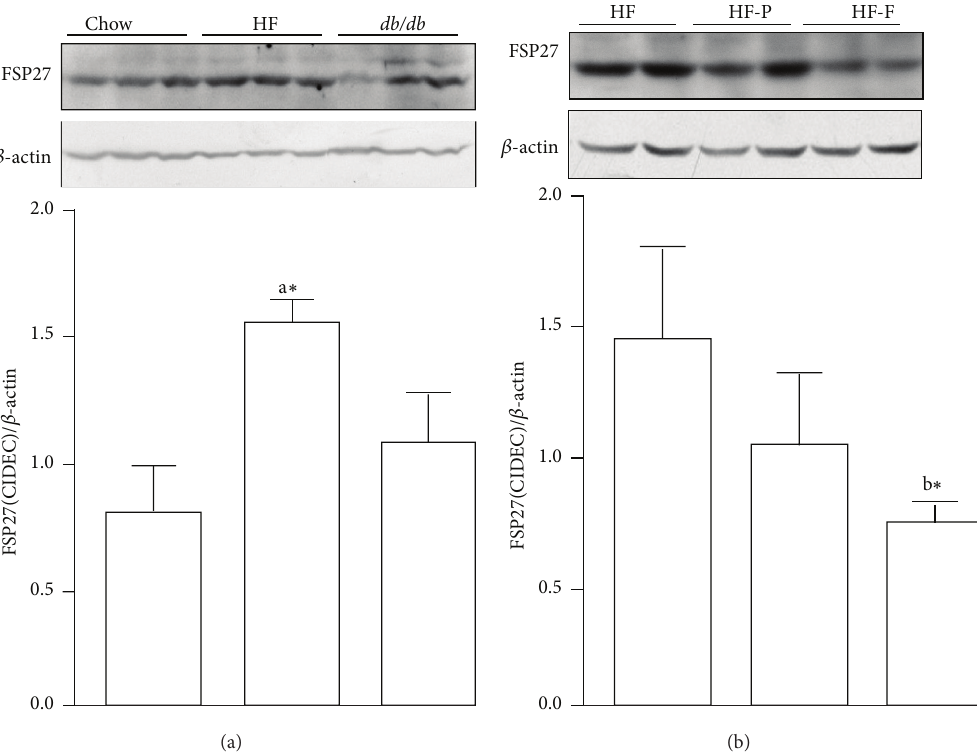
Figure 2: FSP27/CIDEC protein is highly expressed in mouse fatty liver. Immunoblot analyses of FSP27/CIDEC protein abundance in liver lysates (upper panel). Quantification of the protein levels was normalized to 𝛽 -actin (lower panel). (a) FSP27/CIDEC protein level in liver from C57BL/6 mice fed with a normal chow diet (Chow) or high-fat diet (HF) for 20 weeks or from db/db mice. (b) FSP27/CIDEC protein level in liver from mice fed with HF diet and treated with pioglitazone or fenofibrate. Data are the mean ± SEM ( 𝑛 = 4 –7). a: versus Chow